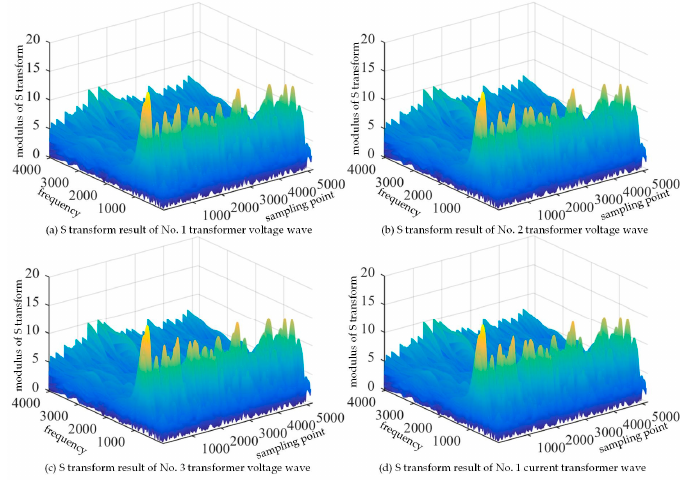
Figure A1. Results of S transform in condition 1.